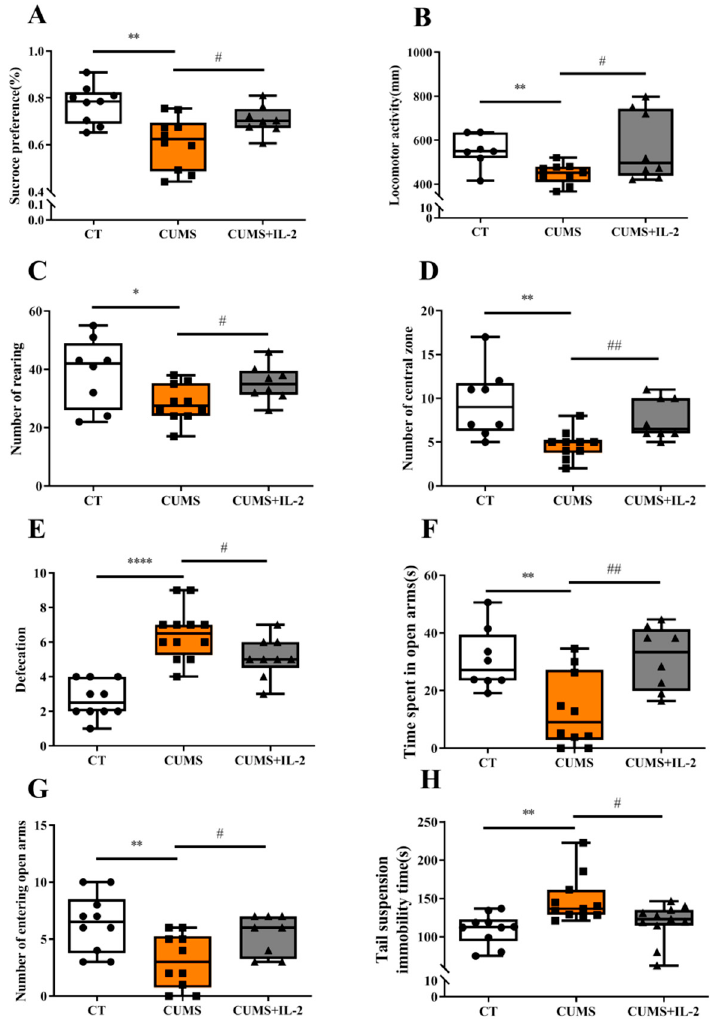
Figure 2. Low-dose IL-2 attenuated anxiety- and depression-like behaviors induced by CUMS exposure. Percentage of sucrose consumption in the sucrose preference test ( A ). Locomotor activity ( B ), number of rearing ( C ), central zone entries ( D ) and defecation ( E ) in the open field test. Time spent ( F ) and number of entries ( G ) into the open arms of the elevated plus maze. Suspension immobility time in the tail suspension test ( H ) (n = 10–12). CT, control; CUMS, CUMS group; CUMS+IL-2, CUMS exposure with IL-2 treatment. **** p < 0.0001, ** p < 0.01, * p < 0.05 vs. CT; # p < 0.05, ## p < 0.01 vs. CUMS.